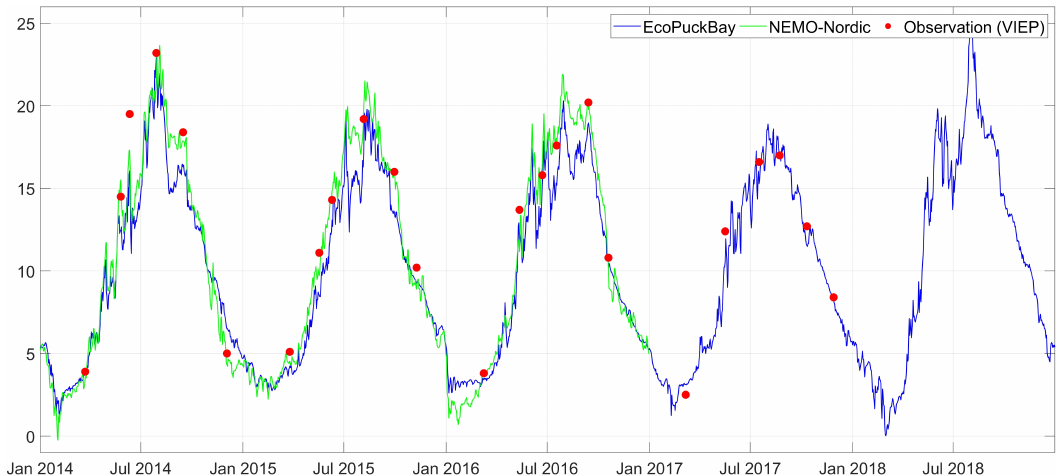
Figure A1. Time series of surface water temperature on station OM1 compared with VIEP observations and NEMO-Nordic model.